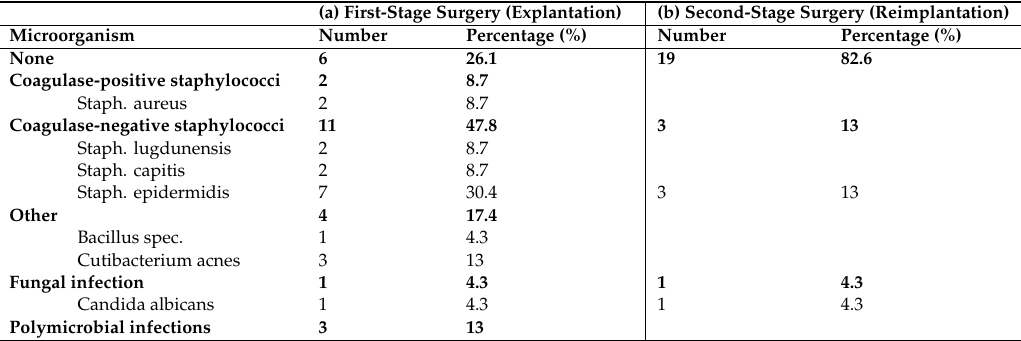
Table2. Microbiologicalresultsfromcollectedintraoperativesamplesduringa)first-andb)second-stage surgery in the articulating spacer group.